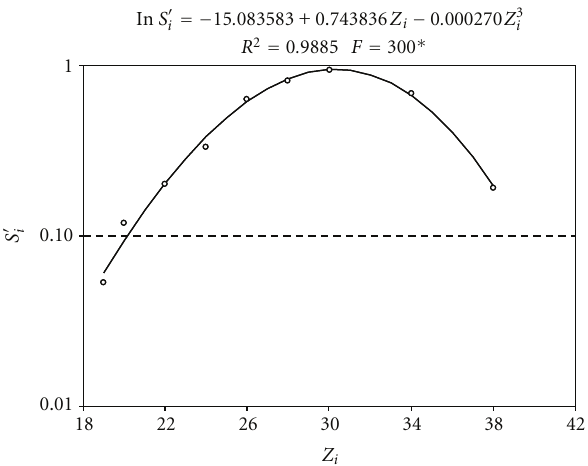
Figure 2: Experimental and calculated relative sensitivity for chemical elements emitting X-K rays for 19 ≤ Z i ≤ 38.